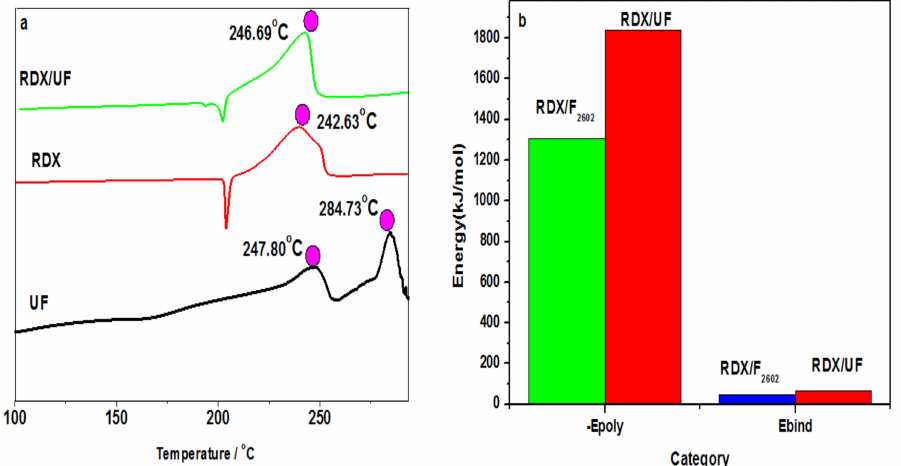
Figure 4. Results of stability analysis: ( a ) di ff erential scanning calorimetry (DSC) method and ( b ) molecular dynamics (MD)